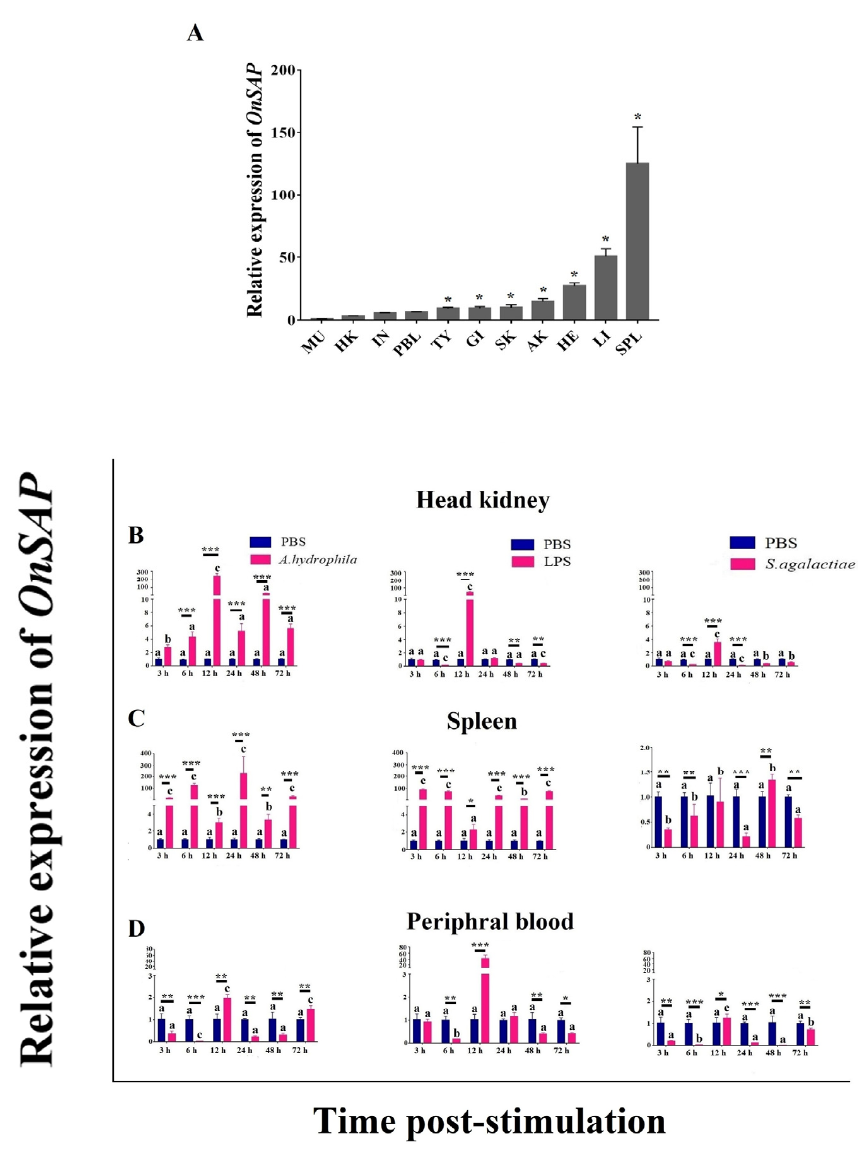
Figure 2. ( A ) Tissue distribution of OnSAP mRNA in healthy Nile tilapia. Muscle was regarded as a standard that could make relative comparison with different tissues and the ratio reflect the comparison normalized against β -actin. The results were mean ± SD of three replicate samples. (SPL: spleen; LI: liver; HE: heart; AK: head kidney; SK: skin; GI: gill; TY: thymus; PBL: peripheral blood; IN: intestinal; HK: trunk kidney; MU: muscle). Asterisks indicate significant differences ( p < 0.05) compared to muscle. Temporal mRNA expression of OnSAP transcript after S. agalactiae (1 × 10 7 CFU/mL), A. hydrophila (1 × 10 7 CFU/mL) and LPS stimulation in the head kidney ( B ), spleen ( C ) and peripheral blood ( D ). Normalization of mRNA level of OnSAP was referred to β -actin and fold units that were calculated deciding the values of the PBS vaccinated tissues. Different letters (a, b, c and *, **, ***, p < 0.05) were calculated by t -test, reflecting the statistical significance among different time points compared with 3th h (a, b, c) or between groups (*, **, ***).